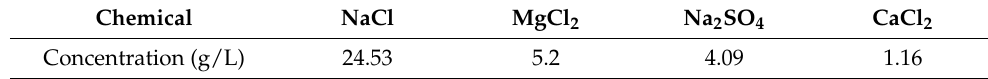
Table 4. Chemical composition of artificial seawater used in current